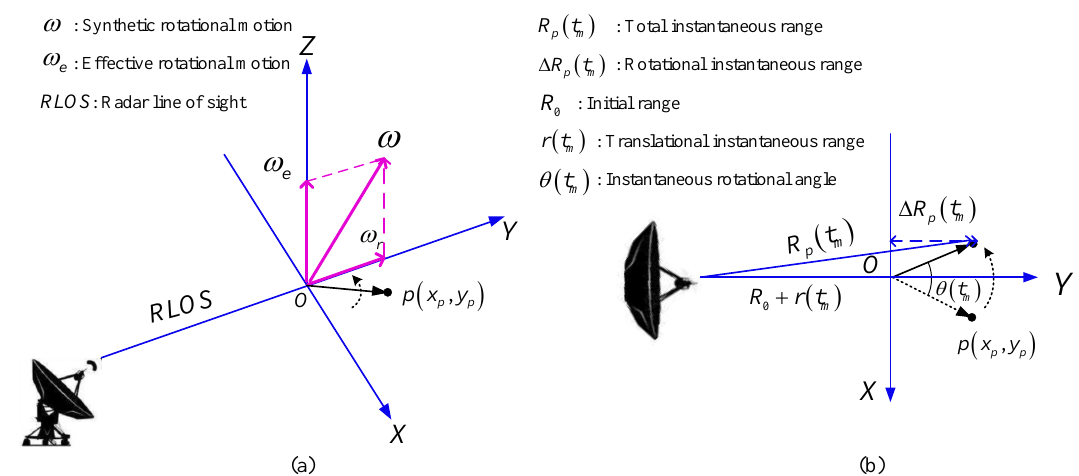
Figure 1. Inverse synthetic aperture radar (ISAR) model © 2020 IEEE. ( a ) Three-dimensional (3-D) scenario geometry model. ( b ) Simplified two-dimensional (2-D) scenario geometry